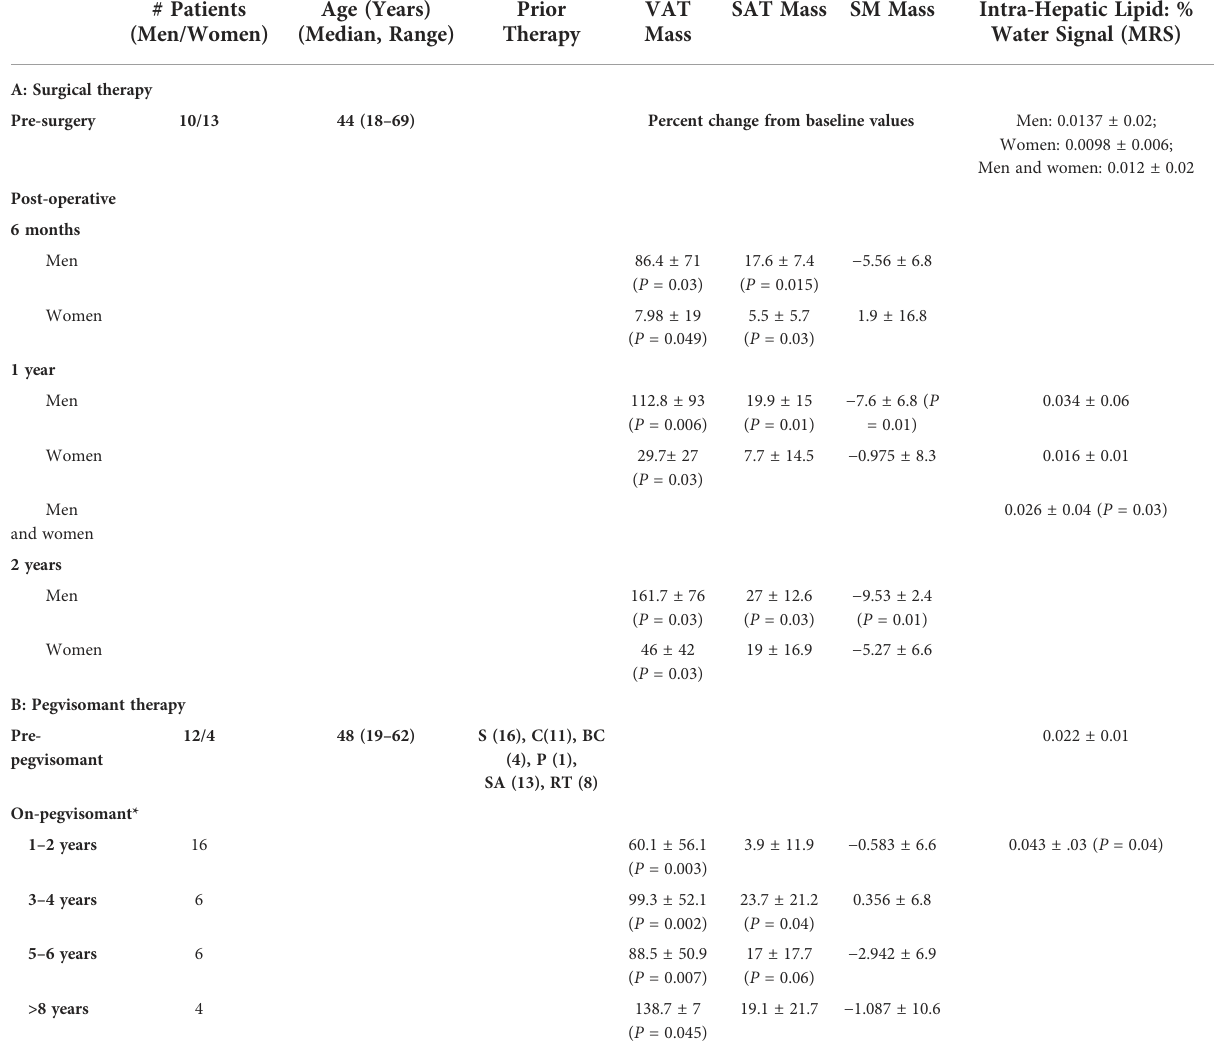
Top:TotalbodyMRImeasuredpercentchangesinVAT(visceraladiposetissue),SAT(subcutaneousadiposetissue),andSM(skeletalmuscle)massesfrompre-operativevaluestothoseat 6 months, 1 year, and 2 years after surgery in men and women, separately. Mean 1 HMRS measured intra-hepatic lipid (IHL) pre-operatively and 1-year post-operatively in men, women, and men and women combined. Bottom: Changes in VAT, SAT, and SM mass from pre-pegvisomant baseline to 1 – 2 years, 3 – 4 years, 5 – 6 years, and ≥ 8 years of pegvisomant therapy